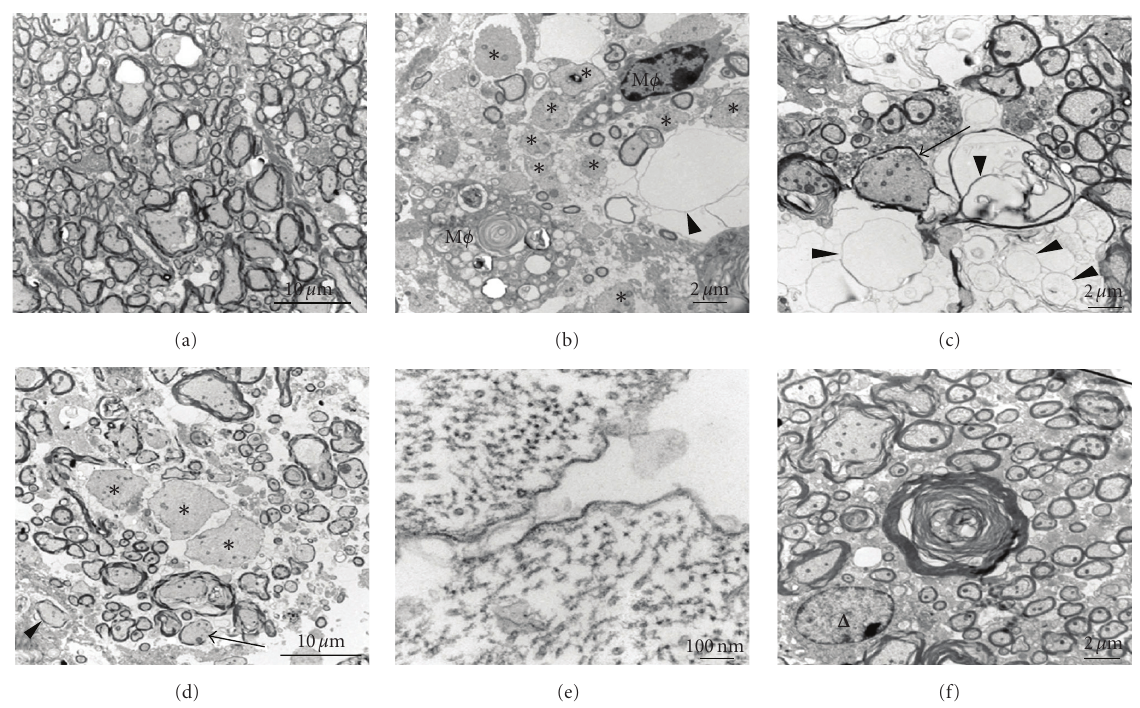
Figure 14: Electron micrographic analysis of demyelination and axonal loss in DM- and NDM-infected mouse spinal cord. Representative foci of demyelination and axonal injury were selected from the toluidine blue-stained sections shown in Figure 3 and processed for electron microscopy. (a) Normal morphology of myelinated axons was exhibited from a non plaque region adjacent to a demyelinated plaque of DM-infected mouse spinal cord. (b–d) Demyelinating plaque in DM-infected mouse spinal cord showed extensive loss of myelin, hypomyelination (arrows), complete axonal degeneration with only residual empty vacuoles (arrowheads), naked axons with no myelin sheath at all ( ∗ ), and macrophages (M φ ). (e) A high-magnification image (120,000x) of a naked axon surrounded only by a single lipid bilayer shows preservation of cytoskeleton elements (microtubules and intermediate filaments). (f) In contrast, NDM-infected mouse spinal cords show only rare examples of early axonal degeneration. (cid:2) Marks an oligodendrocyte nucleus. Such early axonal degeneration was not observed in mock-infected mice. Original magnifications: (a) 3000x, (b) 5000x, (c) 6000x, (d) 3000x, (e) 120,000x, and (f) 6000x. (Adapted from the work of [73]) .